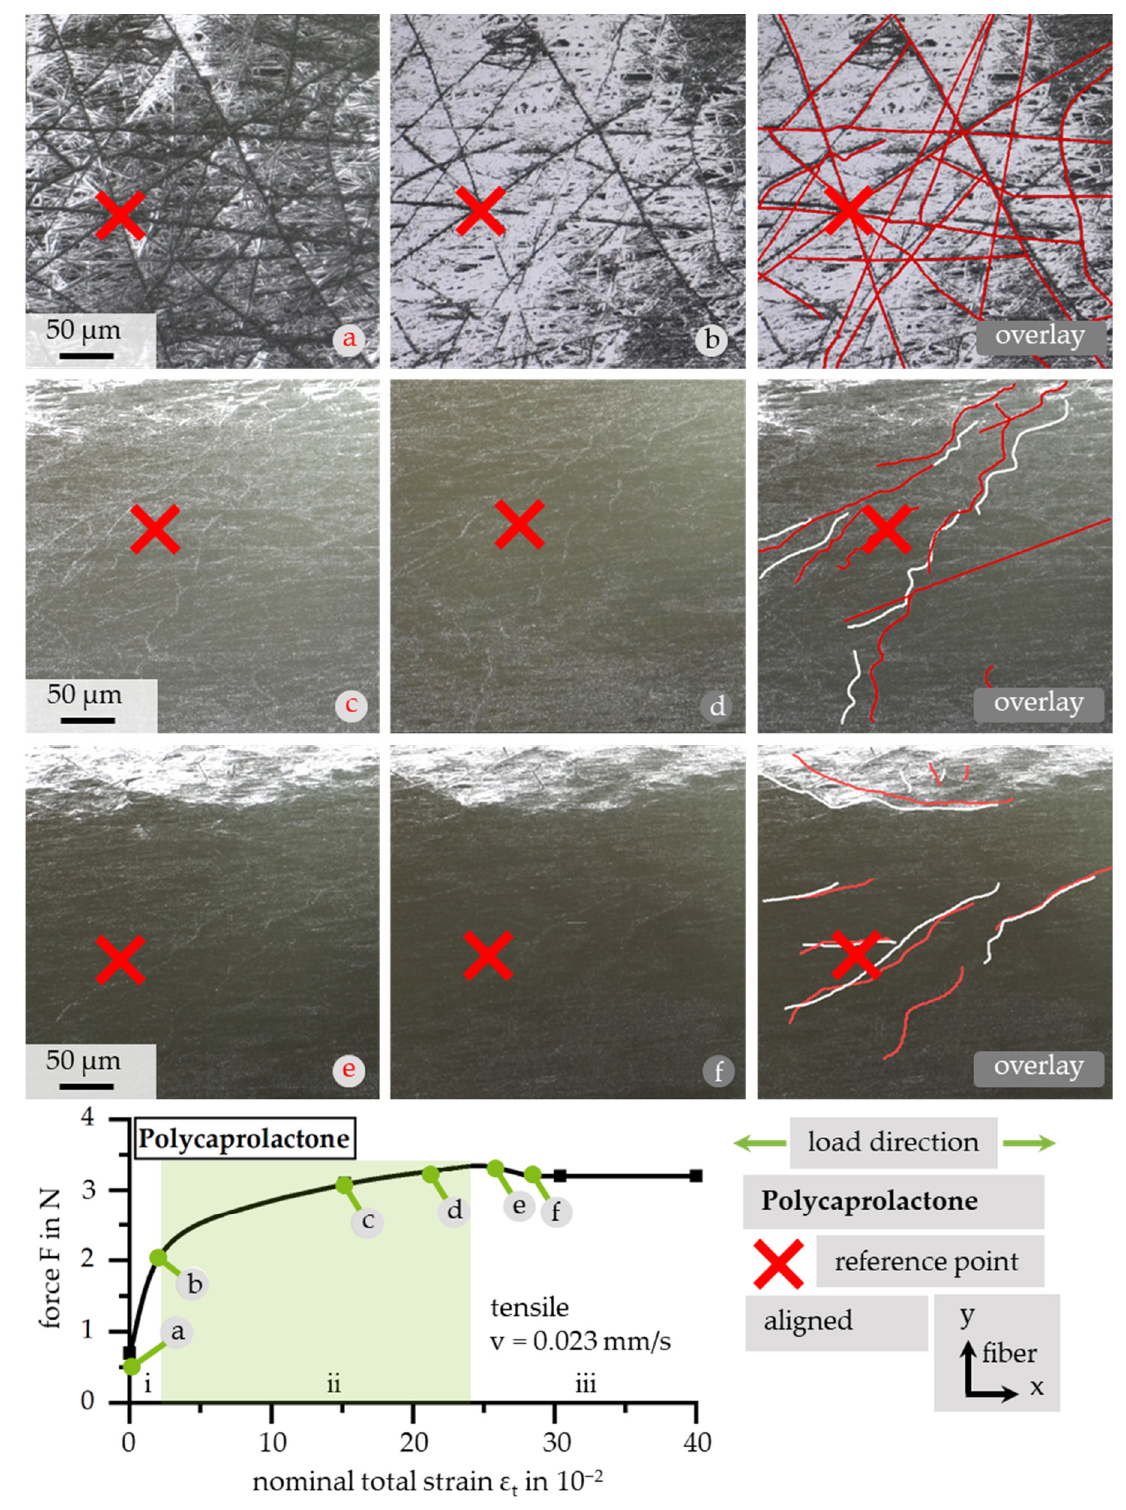
Figure 9. Definition of three nominal total strain sections with reference to an exemplary force—nominal total strain curve. Development of fiber movement and alignment due to tensile load with overlay illustration of distinctive fibers and the mapping of conditions along the force–strain curve. The superimposed image is denoted by the used overlay color.